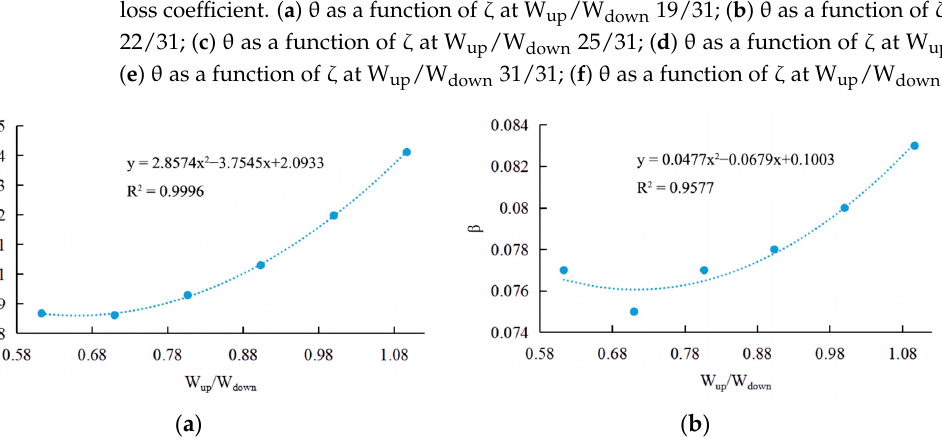
Figure 7. W up /W down as a function of coefficient. ( a ) W up /W down as a function of coefficient α ; ( b ) W up /W down as a function of coefficient β .